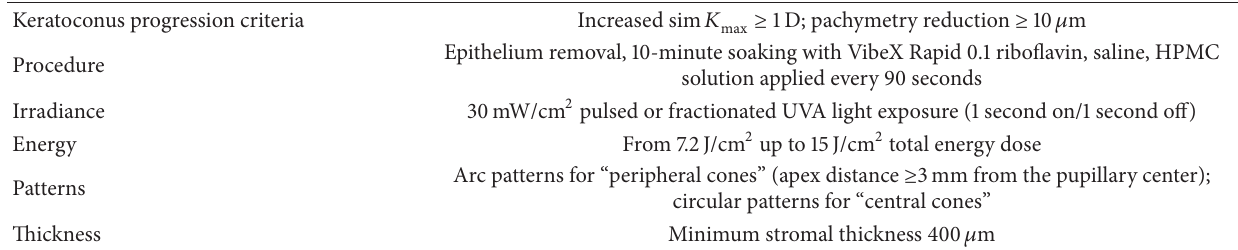
Table 1: Inclusion criteria and treatment protocol.